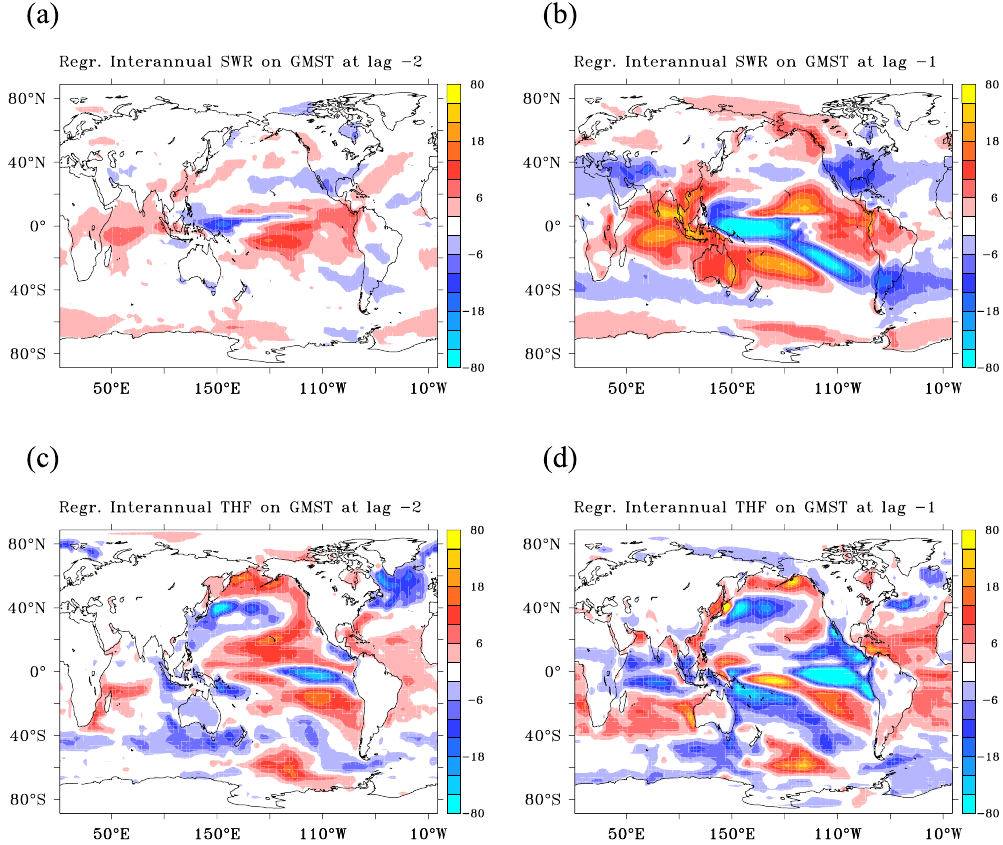
Figure 4. The SWR and THF patterns preceding an inter-annual GMST anomaly. ( a – d ) Regression patterns at different lags. Net shortwave radiation leading GMST by 2 years ( a ), and 1 year ( b ). Turbulent flux leading GMST by 2 years ( c ), and 1 years ( d ). All regression patterns are in (W m − 2 K − 1 ). In ( a , d ) colour intervals are 4 W m − 2 K − 1 , but the first and last intervals are − 80 to − 26 and 26 to 80 W m − 2 K − 1 . Only significant values using 95% confidence intervals are shown. This figure has been created with the free Ferret software package developed by the National Oceanic and Atmospheric Administration (NOAA) and available from www.ferret.